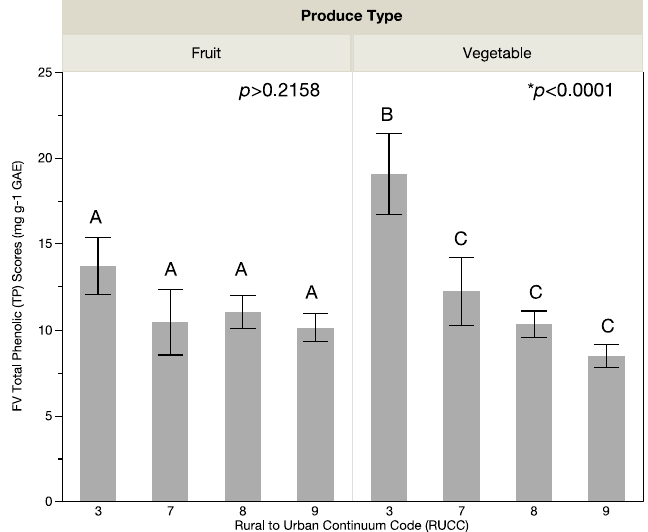
Figure 2. Variation of fruit quality and vegetable quality based total phenolic (TP) scores with rurality. No significant difference was found in fruit quality based on TP scores with rurality. Vegetable quality as determined by vegetable total phenolic (TP) scores is lower in more rural areas (higher rural urban continuum codes (RUCC) represent more rural areas). RUCC codes that have the same letter (A or B) above the standard error bar in the graph show no statistical difference while RUCC codes that have different letters above the bar in the graph are statistically different. Each error bar is constructed using one standard error from the mean.